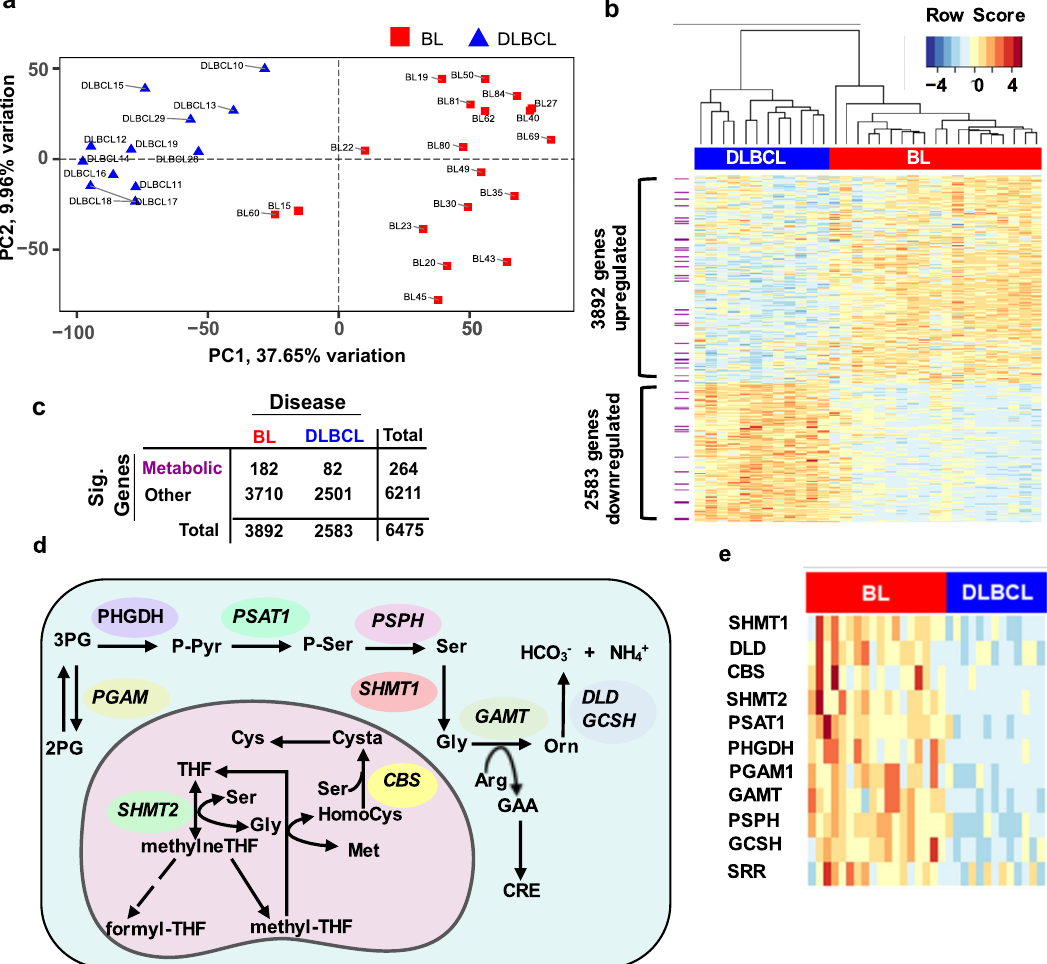
Figure 2. Genetic differences between BL and DLBCL. Principal component analysis performed on transcriptome profiles of 19 endemic BL and 12 GCB-DLBCL cases. ( a ) The first and second principal components are contributing to 37.65% and 9.96% of the total explained variation, respectively. The marker shapes represent the origin of isolated malignant B-cells: abdomen (circle), bone marrow (BM, triangle), jaw (square), lymph nodes (LN, cross), neck (square cross) and pelvic (star). ( b ) The 6475 statistically significant altered genes (FDR < 0.01) from differential expression analysis are visualised in a heatmap. Gene expression values have been converted to a Z-score scale along the rows for case comparisons. The dendrogram in hierarchical clustering analysis was produced with the Ward method and distance 1-Spearman’s rank correlation. ( c ) Contingency table used for two-sided Fisher’s Exact test to compare the relative proportions of significant genes between the BL and DLBCL. ( d ) Illustration of the genes involved in serine metabolism. ( e ) Heatmap of statistically significant genes associated with serine metabolism in DLBCL and BL. Abbreviations: SHMT1: serine hydroxy methyltransferase 1; DLD: dihydrolipoamide dehydrogenase; SHMT2: serine hydroxy methyltransferase2; CBS: cystathionine beta synthase; PSAT1: Phosphoserine aminotransferase; PHGDH: phosphoglycerate dehydrogenase; PGAM1: phosphoglycerate mutase 1; GAMT: guanidinoacetate methyltransferase; PSPH: phosphoserine phosphatase; GCSH: glycine cleavage system protein H; SRR: serine racemase. Dendrogram in hierarchical clustering analysis was produced with Ward method and distance 1- Spearman’s rank